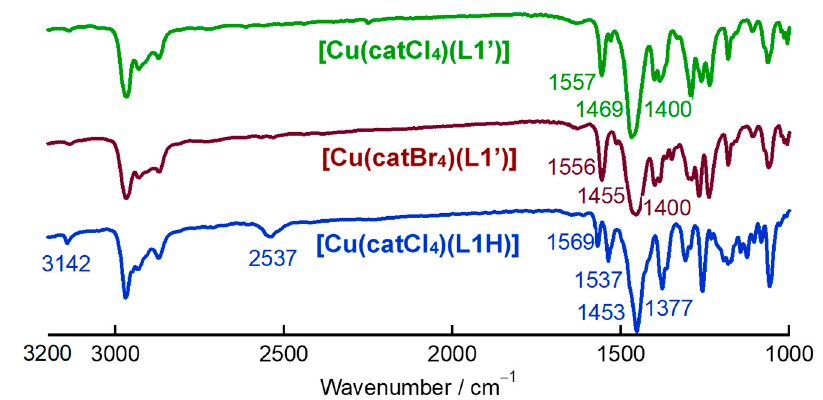
Figure 3. IR spectra of [Cu(catCl 4 )(L1 ′ )] ( top ), [Cu(catBr 4 )(L1 ′ )] ( middle ), and [Cu(catCl 4 )(L1H)] ( bottom ) measured by KBr pellets.